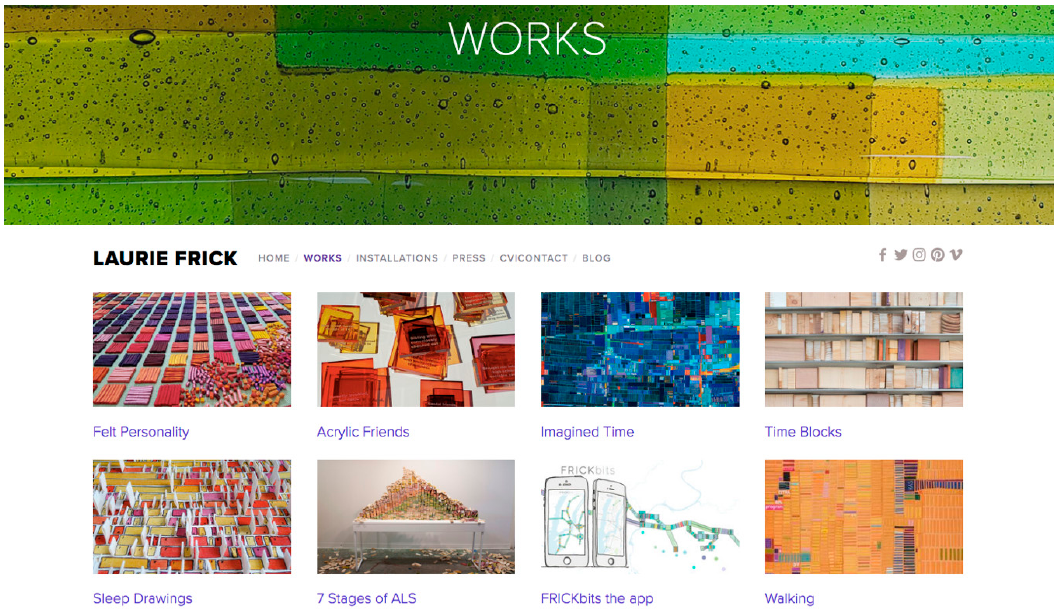
Figure4. WorksofLaurieFrickscreenshotoftheWebpagehttps: // www.lauriefrick.com / works. Courtesy Figure 4. Works of Laurie Frick screenshot of the Webpage https://www.lauriefrick.com/works . of the Courtesy of the author.